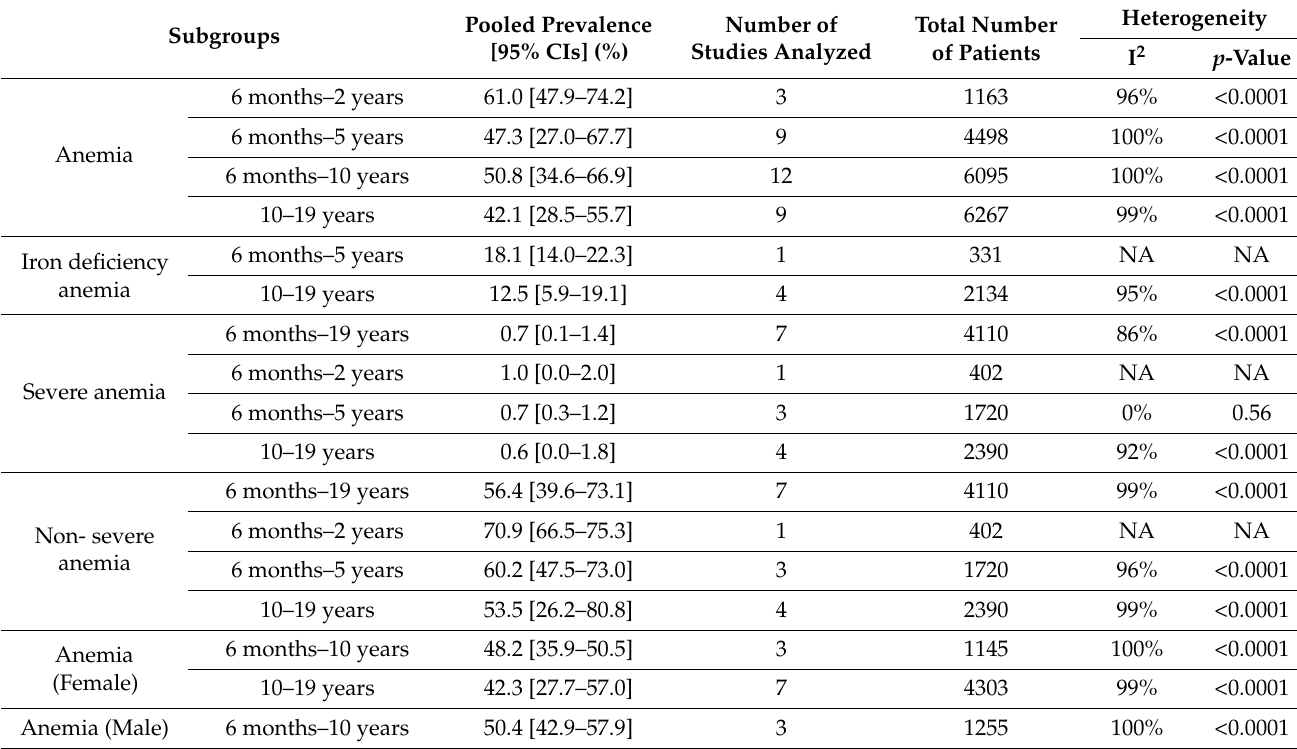
Table 2. Pooled prevalence of anemia in different subgroups of children and adolescents of Bangladesh.